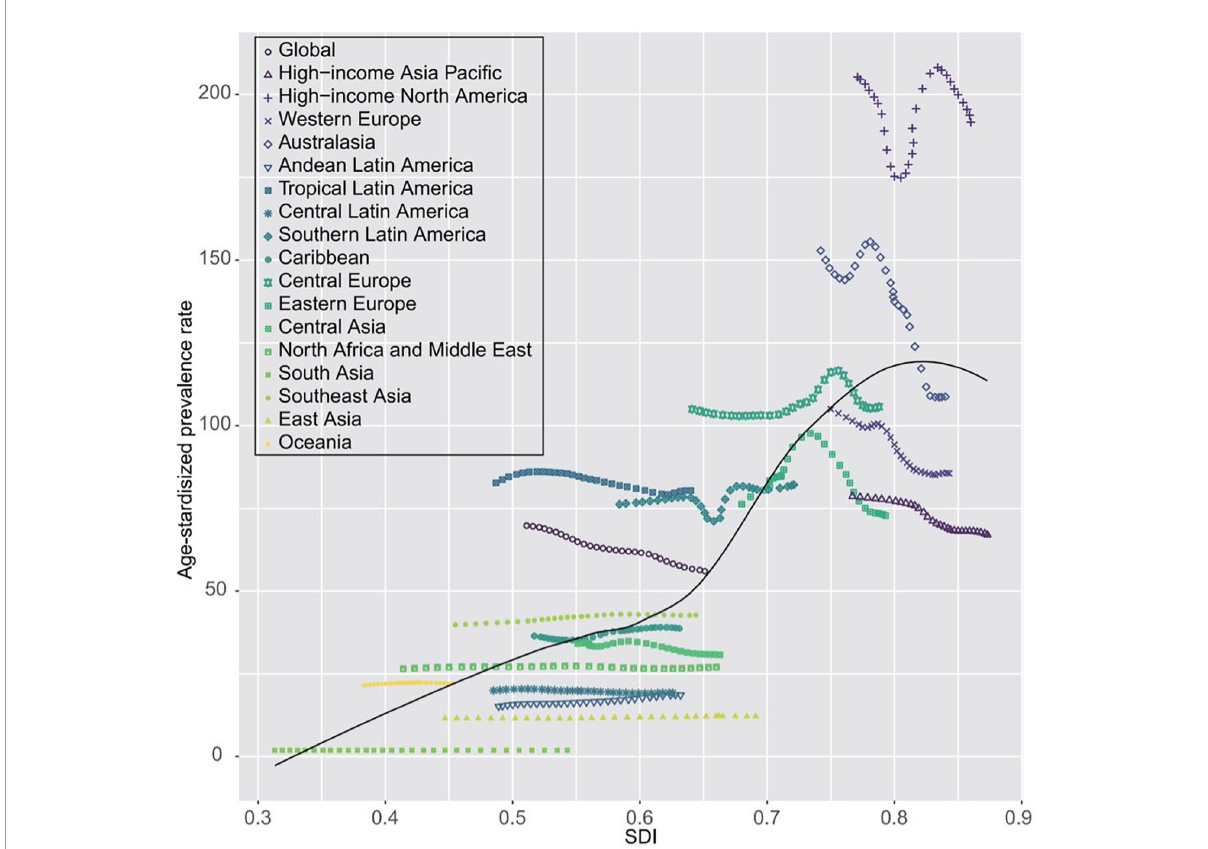
FIGURE3 Temporal trends in age-standardized death rates of cardiomyopathy for 21 world regions by SDI, both sexes, 1990–2019. For each region, points from left to right depict estimates from each year from 1990 to 2019. SDI, socio-demographic